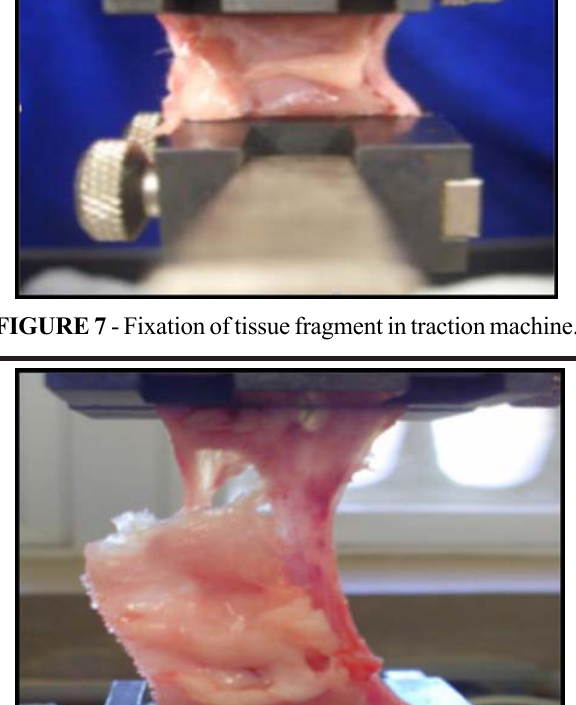
FIGURE 3 - Closing of the deformity with polypropylene mesh.